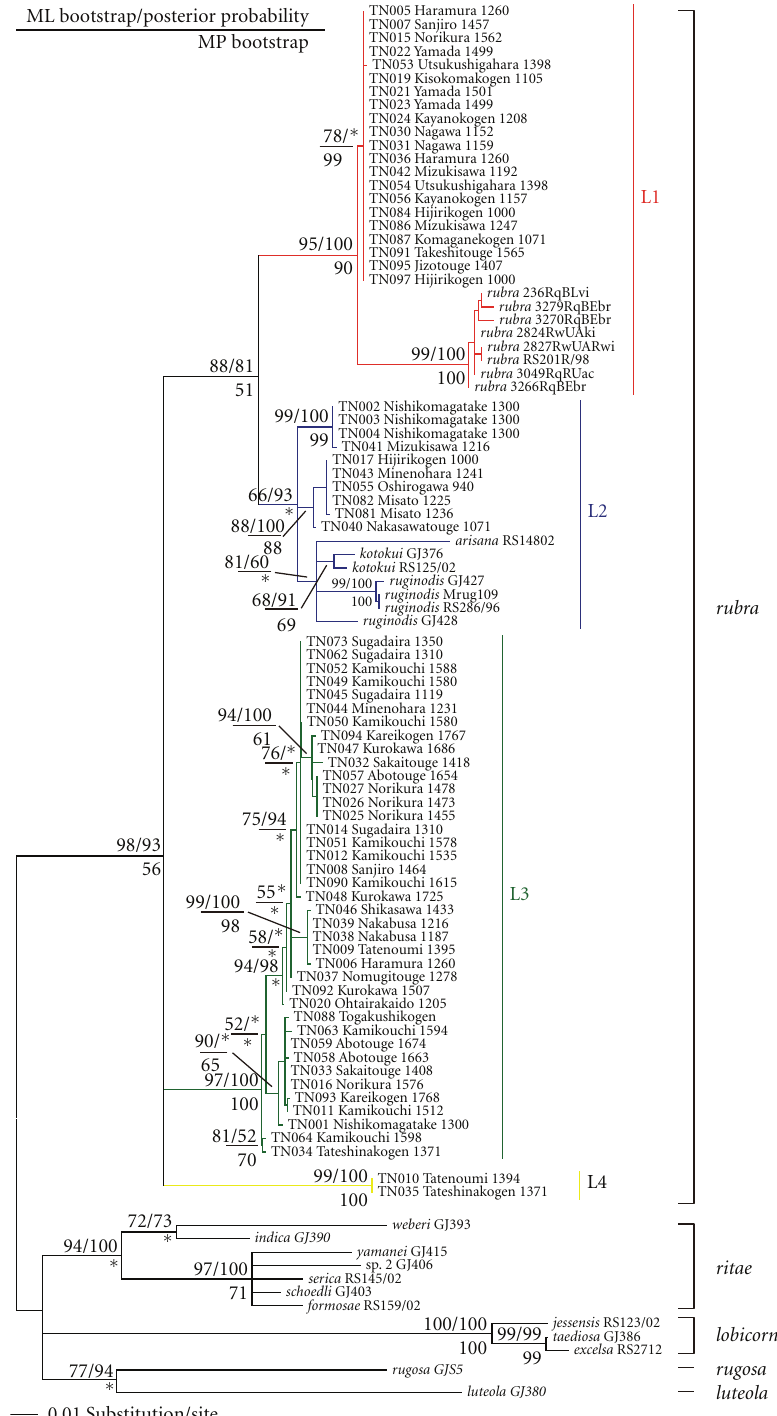
Figure 2: Maximum likelihood phylogeny of Myrmica kotokui estimated by using the 508 bp mitochondrial DNA sequences of cytochrome oxidase I and the 347 bp nuclear DNA sequences of long-wavelength rhodopsin . The numbers above the branches are the ML bootstrap support/Bayesian posterior probability, and those below the branches are the MP bootstrap support. An asterisk ( ∗ ) replacing a node support value indicates that the node was not recovered in the MP bootstrap or Bayesian posterior probability analysis. The sample names in the phylogeny are referred to Table